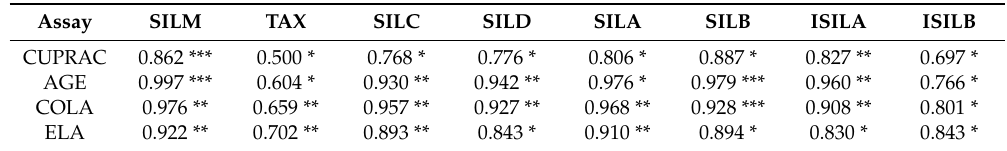
Figure 5. Heatmap showing the phytochemical composition and biological activities relevant to cosmetic of the 27 extracts from S. marianum mature fruit following UAE. Two antioxidant assays were conducted: CUPRAC (expressed as ascorbic acid equivalent antioxidant capacity (AEAC, in µM AEAC)) and the inhibition of advanced glycation end product (AGE) formation (expressed in % of inhibition relative to a control obtained by measuring the activity of the corresponding extraction solvent). Two anti-aging assays were conducted by determining the inhibition activity of each extracts toward collagenase (COL) and elastase (ELA) enzymes (expressed in % of inhibition relative to a control obtained by measuring the activity of the corresponding extraction solvent). Table 6. Pearson coefficient correlation (PCC) linking SILM and its constituents to the in vitro antioxidant and in vitro cell-free anti-aging activities.